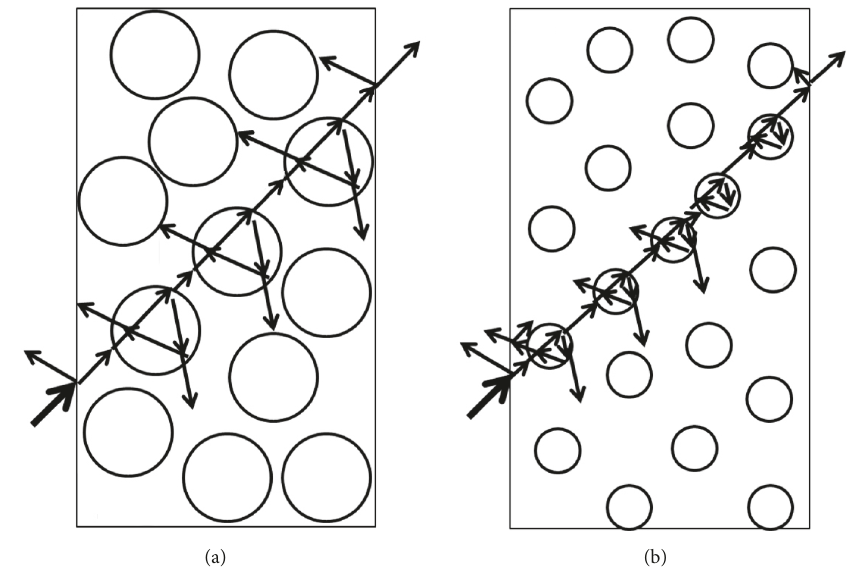
Figure 7: Acoustic principle diagram of foam material: (a) NBR-PVC, (b)